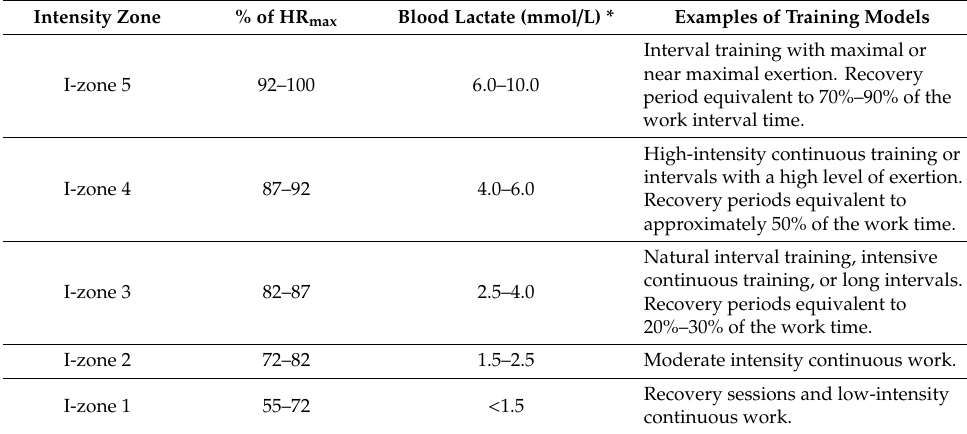
Table 2. The exercise intensity scale developed by the Norwegian Olympic Centre (NOC) used for classification of training intensity